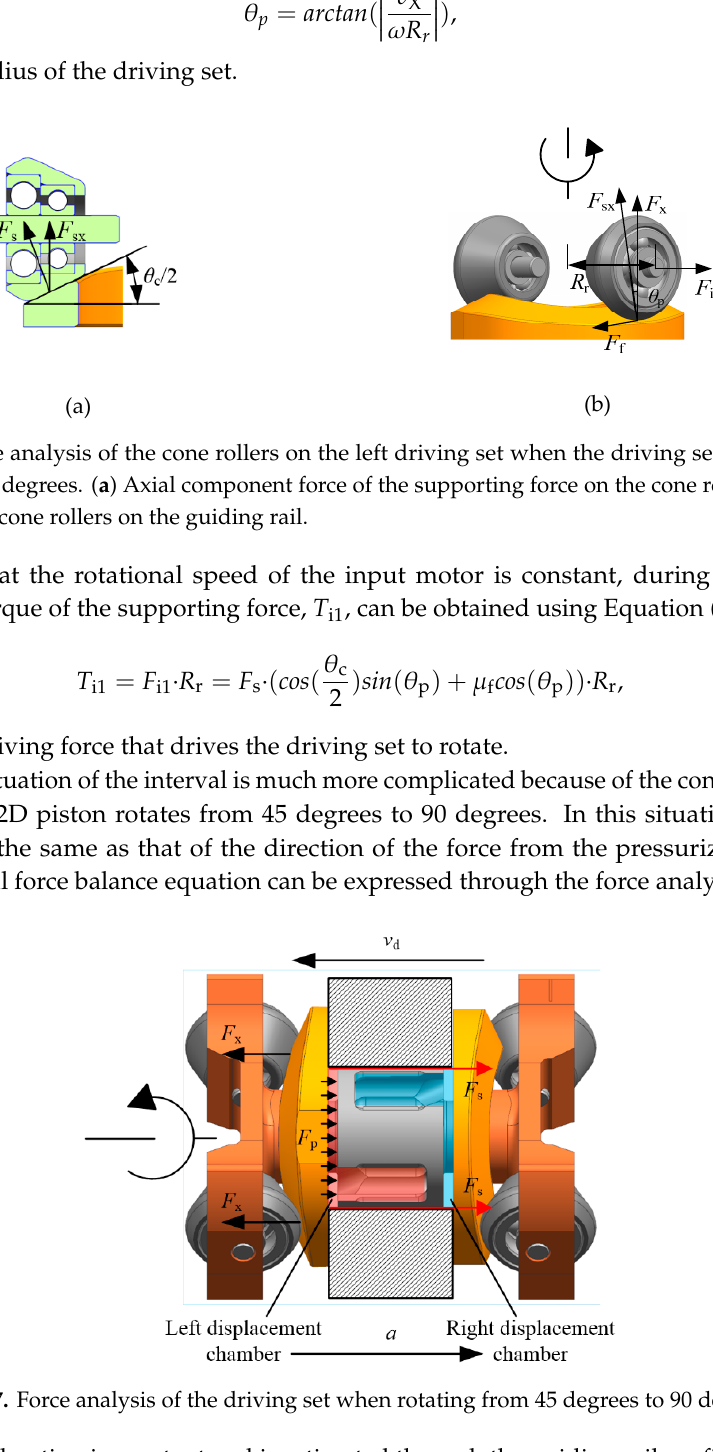
Figure 6. Force analysis of the cone rollers on the left driving set when the driving set rotates from 0 degrees to 45 degrees. (a) Axial component force of the supporting force on the cone roller; (b) force analysis of the cone rollers on the guiding rail.